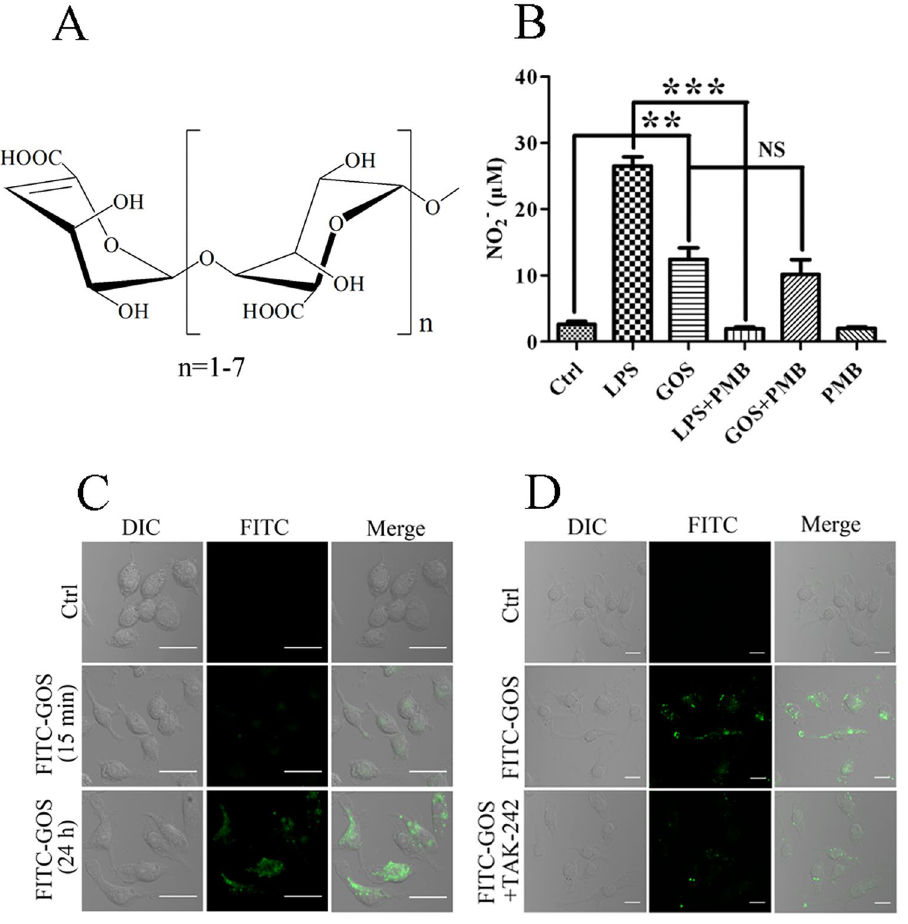
Figure 1. Endotoxin contamination tests and macrophage endocytosis of GOS. ( A ) Stereo-image of structure of alginate-derived GOS. ( B ) RAW264.7 cells were incubated with LPS (1 μ g/ml, as a positive control) and GOS (1 mg/ml) in the presence or absence of the LPS inhibitor PMB (0.25 μ g/ml) for 24 h. Nitrite levels in the culture medium of treated cells were measured using the Griess assay. ( C ) RAW264.7 cells were incubated with 1 mg/ml FITC-GOS for 15 min and 24 h and observed by laser scanning confocal microscopy (40x). ( D ) RAW264.7 cells were pre-incubated for 2 h with the TLR4 inhibitor TAK-242 (1 μ M), then incubated with 1 mg/ml FITC-GOS for 22 h, and observed by laser scanning confocal microscopy (40x). Representative images and results from three independent experiments are shown. Scale bar = 20 μ m. NS, no significance. ** P < 0.01, *** P <